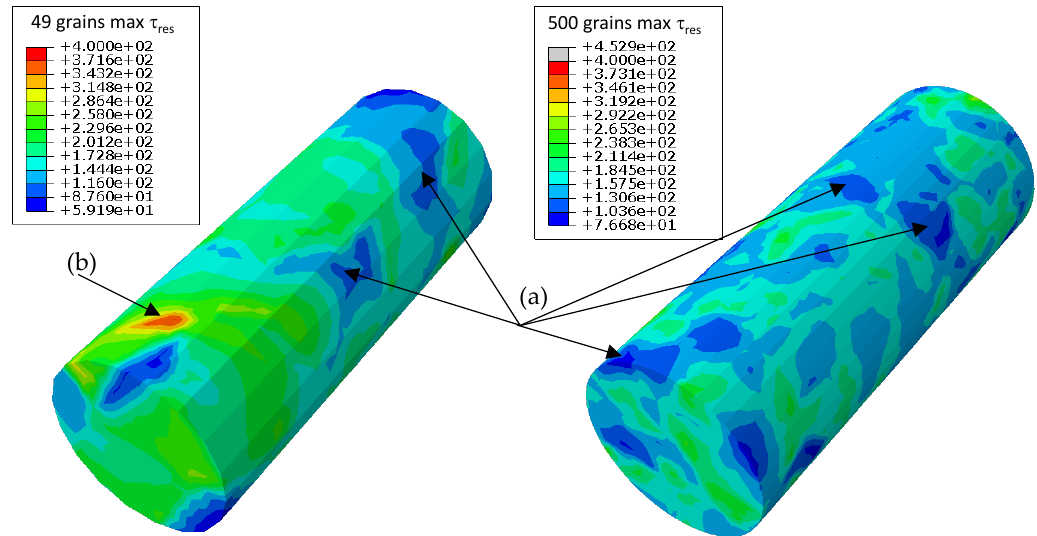
Figure 11. Distribution of maximum resulting shear stress in the < 111 > {110} slip systems at total strain of 0.25%. Coarse grain morphology and random orientation to the left and fine grain morphology with preferential orientation ( ϑ = 25 ◦ ) to the right.